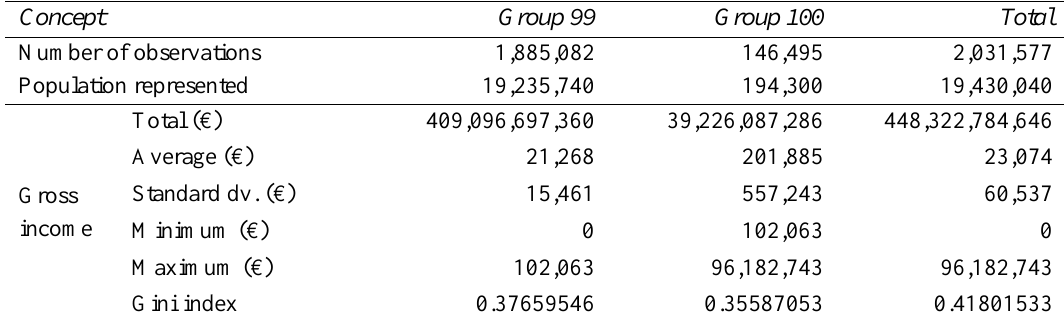
Table 1 . Descriptive statistics of the 2011 Spanish PIT